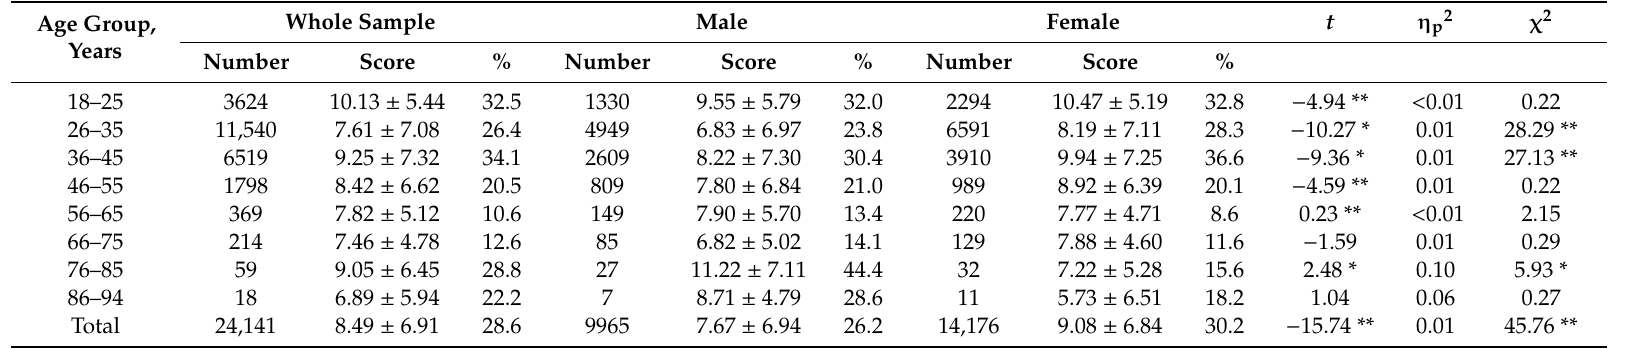
Table 2. Depression scores and prevalence among participants of di ff erent genders and